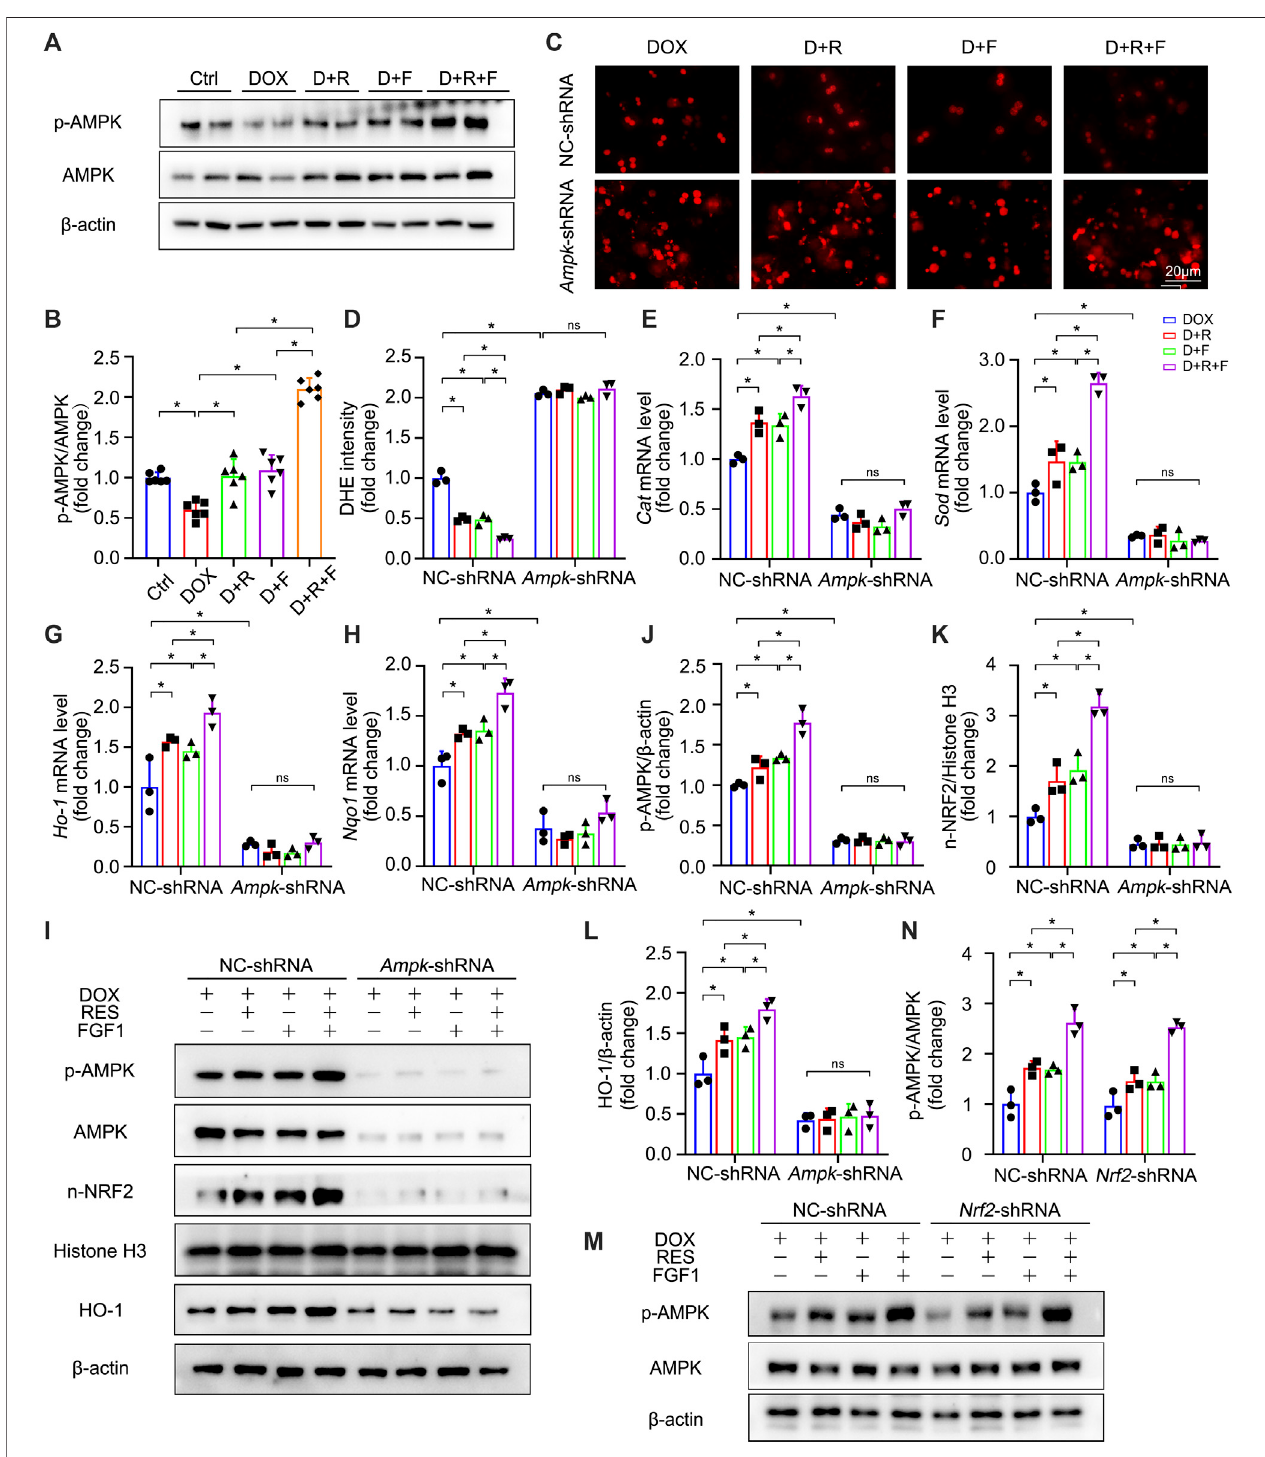
FIGURE 5 | AMPK was identi fi ed as a positive upstream regulator of NRF2, which was activated upon co-treatment of primary hepatocytes with RES and FGF1. (A,B) Relative protein expression levels of p-AMPK and AMPK and quanti fi cation of their expression ( n = 6). (C,D) Representative fl uorescence microscopy images of DHE-stained primaryhepatocytesoftheindicatedgroups( n =3). (E – H) RelativemRNAexpressionlevelsofoxidativestressmarkers Cat , Sod , Ho-1, and Nqo1 inprimaryhepatocytesafterthe indicated treatments ( n = 3). (I-L) Relative protein expression levels of proteins involved in AMPK signaling (p-AMPK/ β -actin) and NRF2 signaling (n-NRF2 and HO-1) after transfectionofprimaryhepatocyteswith Ampk -shRNA,andquanti fi cationoftheirlevels. (M,N) Relativeproteinexpressionlevelsofp-AMPKandAMPKinprimaryhepatocytesof the different groups after transfection with Nrf2 -shRNA, and quanti fi cation of their levels. Three independent experiments were performed. β -actin or histone H3 served as the loading control for all western blot analysis. Data are expressed as mean ± SD. * p < 0.05; ns indicates not signi fi cant.